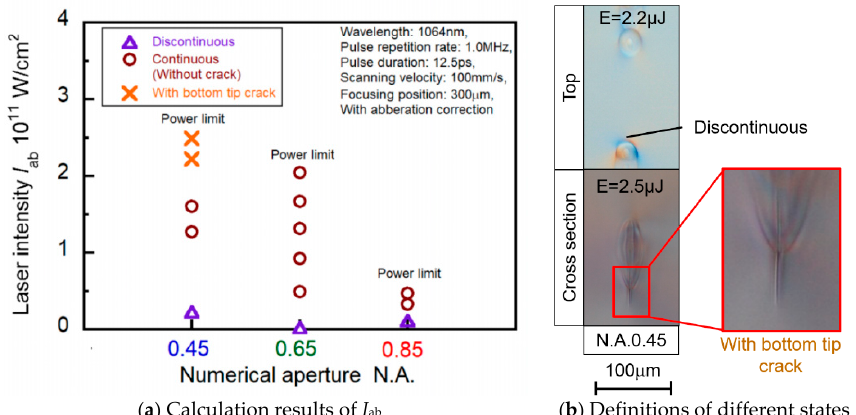
Figure 13. Influence of numerical aperture on state of molten area.